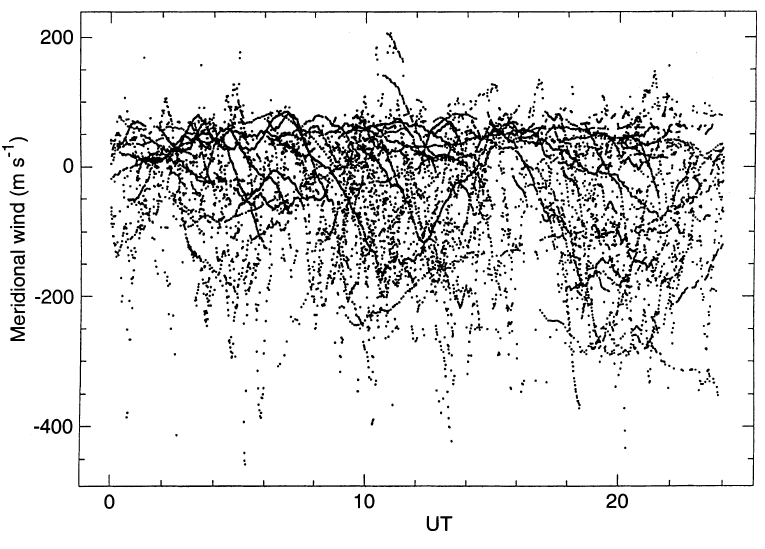
Fig. 2. Quiet-time wind data base around 250 km height